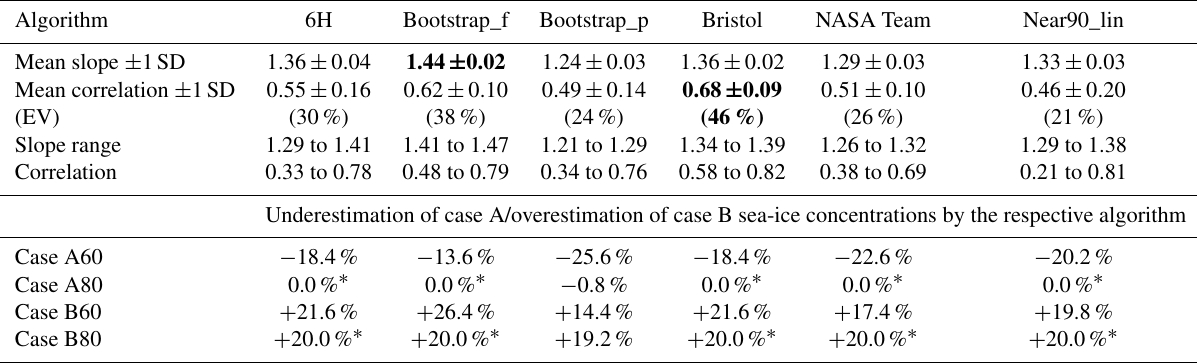
Table 12. Slope of the linear relationship and correlation between AMSR-E sea-ice concentrations and MODIS ice-surface fractions for the six algorithms, which do not cut off sea-ice concentrations, averaged over the six pentads from 11–15 July to 6–10 August. For each algorithm, the average value ± 1 standard deviation (SD), the range in the slope values, and the range in the correlations are given. (EV) denotes the explained variance. Cases A60 and A80 denote 100% sea-ice concentration with 40 and 20% (apparent) open-water fraction due to melt ponds, i.e., 60 and 80% ice-surface fraction, respectively. Case B60 and B80 denote 60 and 80% sea-ice concentration in the case of 40 and 20% real open-water fraction; i.e., the ice-surface fraction = the sea-ice concentration. A “ ∗ ” indicates saturation; i.e., the retrieved AMSR-E sea-ice concentration exceeds 100%. Bold numbers denote the maximum values for mean slope and mean